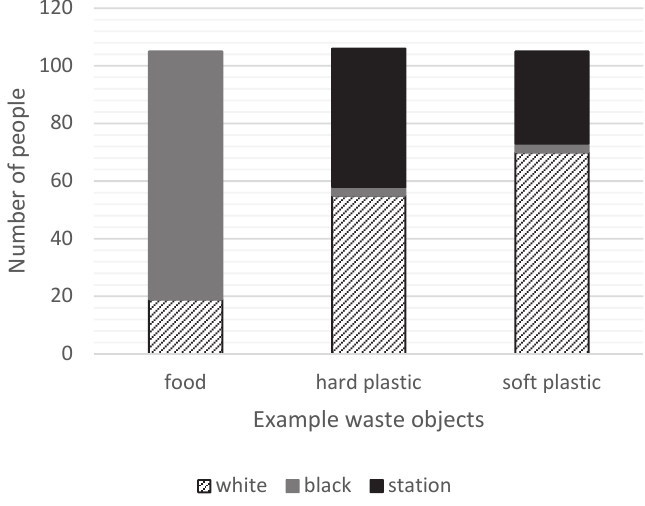
Figure A11. Waste sorting behavior by giving waste examples, first survey (106 individuals).